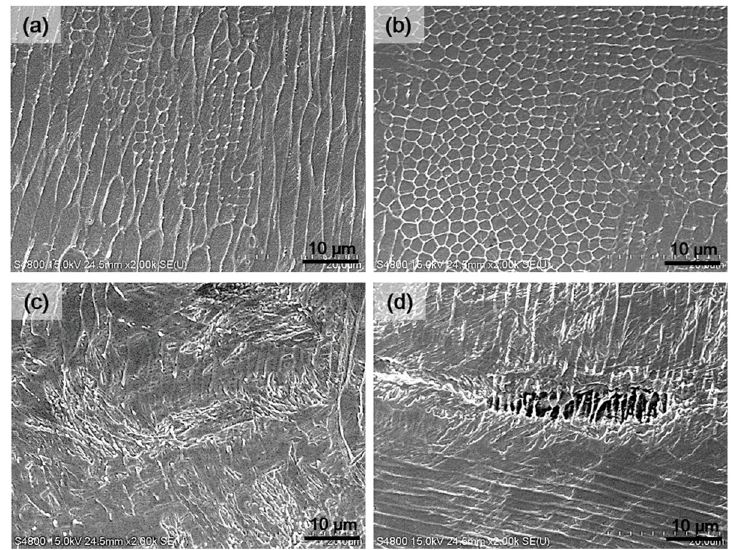
Figure 9. FGM dendrite SEM microstructure images: ( a ) dendrite images began to reveal; ( b ) clear dendrites shown; ( c ) dendrite fading; ( d ) weld bead boundary mushy zone and dendrite internal crack initiation.